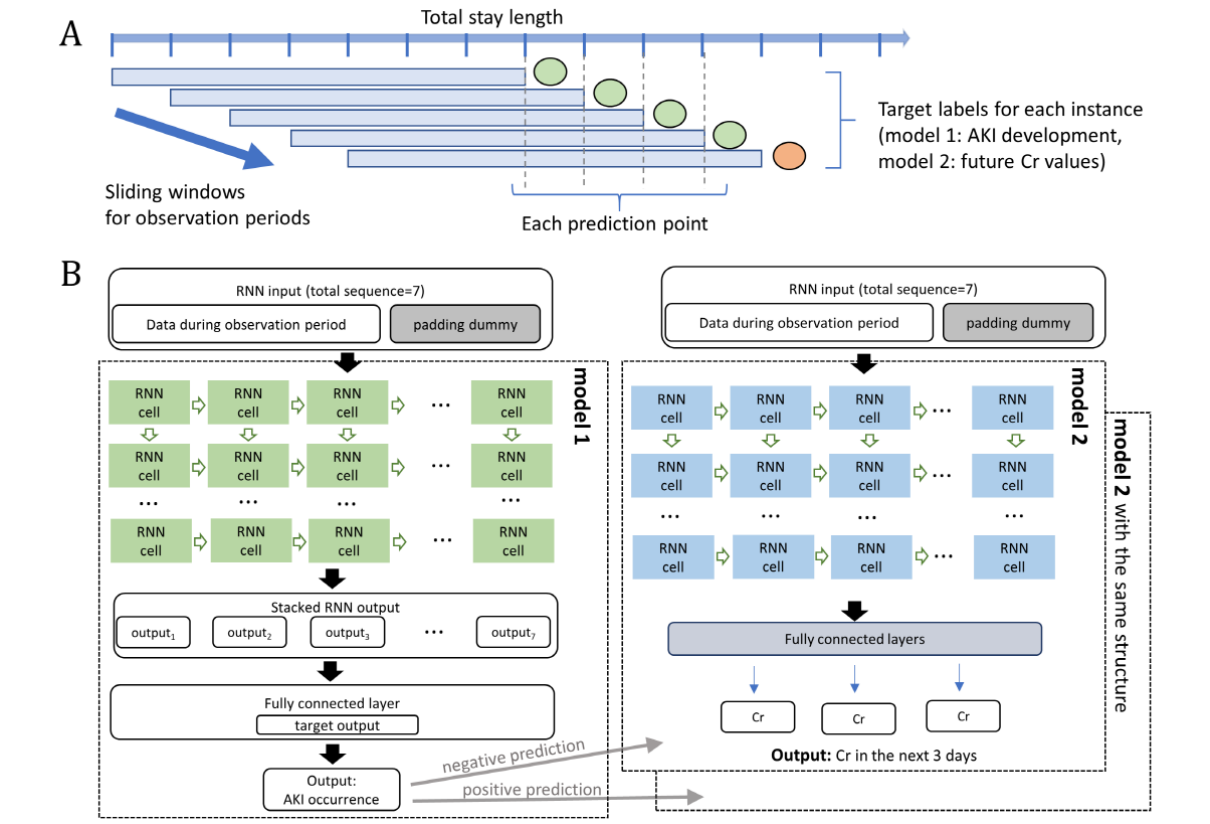
Figure 1. Architectural overview of the developed model using the recurrent neural network (RNN). (A) The sliding window approach for handling sequential data and (B) the 2-stage hierarchical model comprising models 1 and 2. Model 1 could predict the occurrence of acute kidney injury